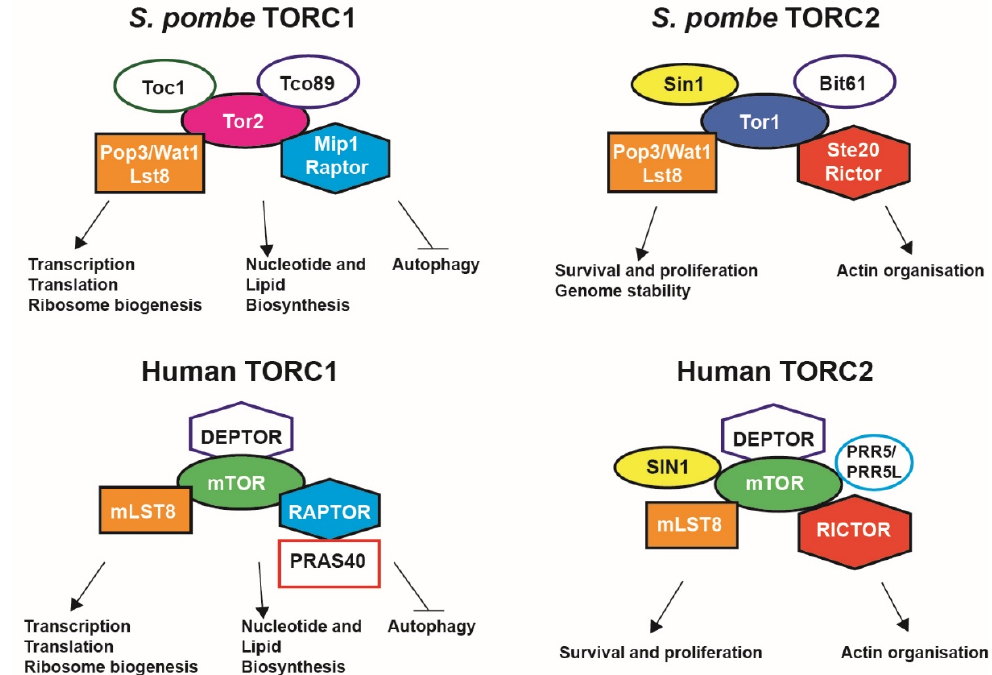
Figure 1. Schizosaccharomyces pombe and human TORC1 and TORC2 complexes. Each complex is composed by a TOR kinase (predominantly Tor2 for TORC1 and Tor1 for TORC2 fission yeast complexes) and at least four partners identified through mass spectrometry approaches. Lst8 is a common partner for both TORC1 and TORC2. However, in fission yeast, Mip1 (RAPTOR), Tco89, and Toc1 are associated with TORC1 only, while Ste20 (RICTOR), Sin1, and Bit61 are associated with TORC2. In human complexes, DEPTOR is found in both complexes, while PRAS40 is associated with TORC1 and PRR5/PRR5L with TORC2. Each complex has pivotal roles in metabolism, cell organization, growth, and survival (see main text for details). mTOR, mechanistic target of rapamy- cin.